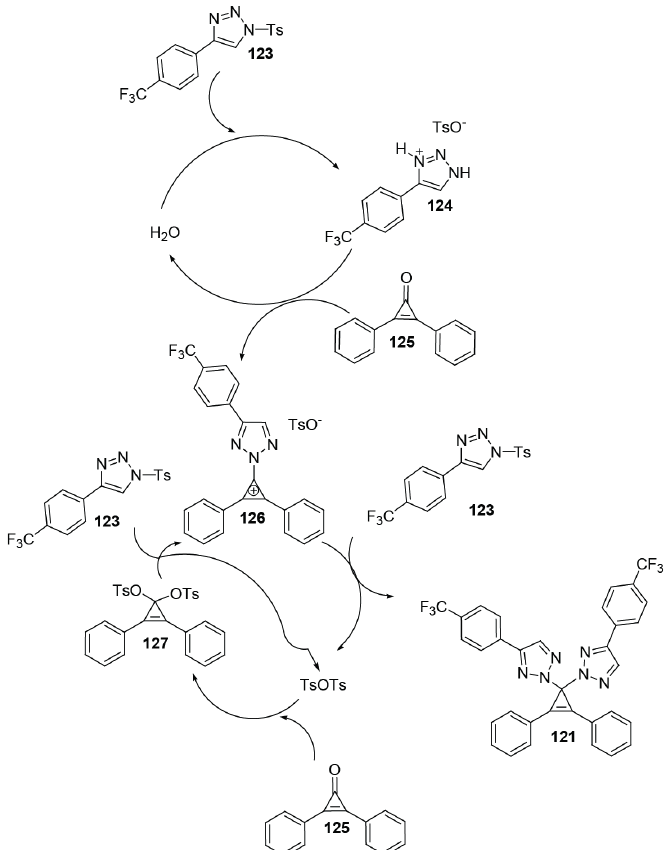
Figure 19 - Proposed autocatalytic mechanism for the ditriazolylation reaction of cyclopropenones.